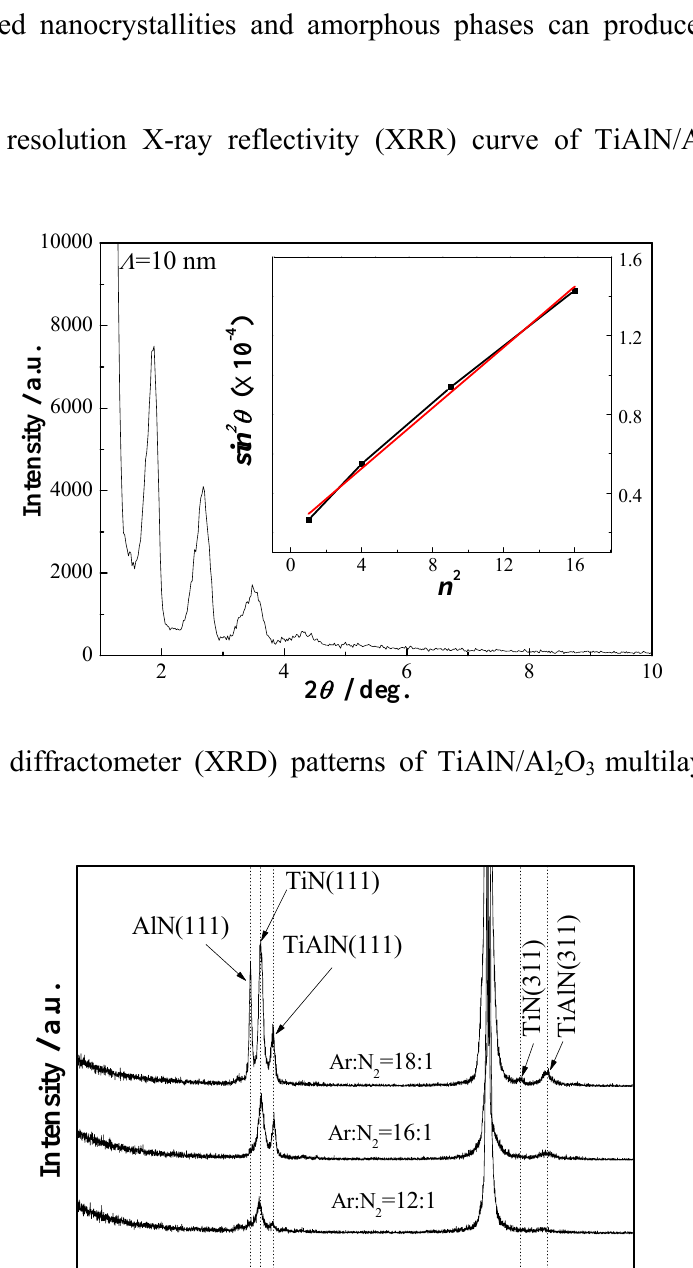
O multilayer 2 3